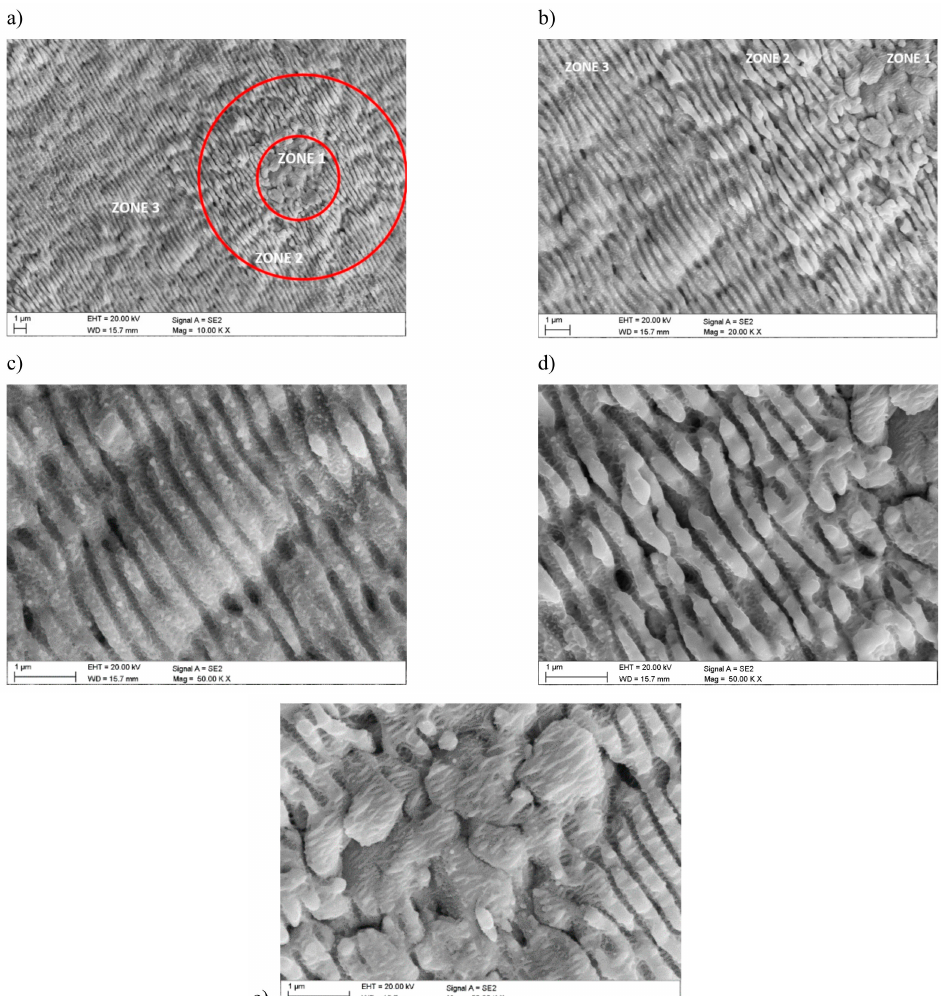
Figure 3. Nanoripples laser-induced periodic surface structures (LIPSS) on surface cemented carbides ( a ) area 10,000 × , ( b ) area 20,000 × , ( c ) area 50,000 × —zone 3, ( d ) area 50,000 x—zone 2, and ( e ) area 50,000 x—zone